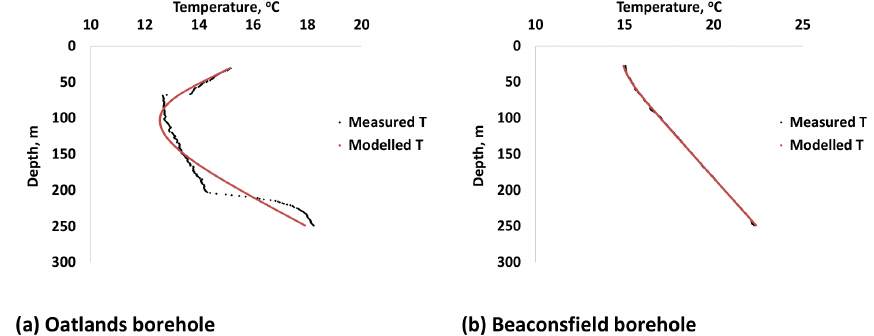
Figure 3. (a) High deviation between measured and modelled temperature–depth profile and borehole records classified as low quality. (b) Very low deviation between measured and modelled temperature–depth profile and borehole records classified as high quality.